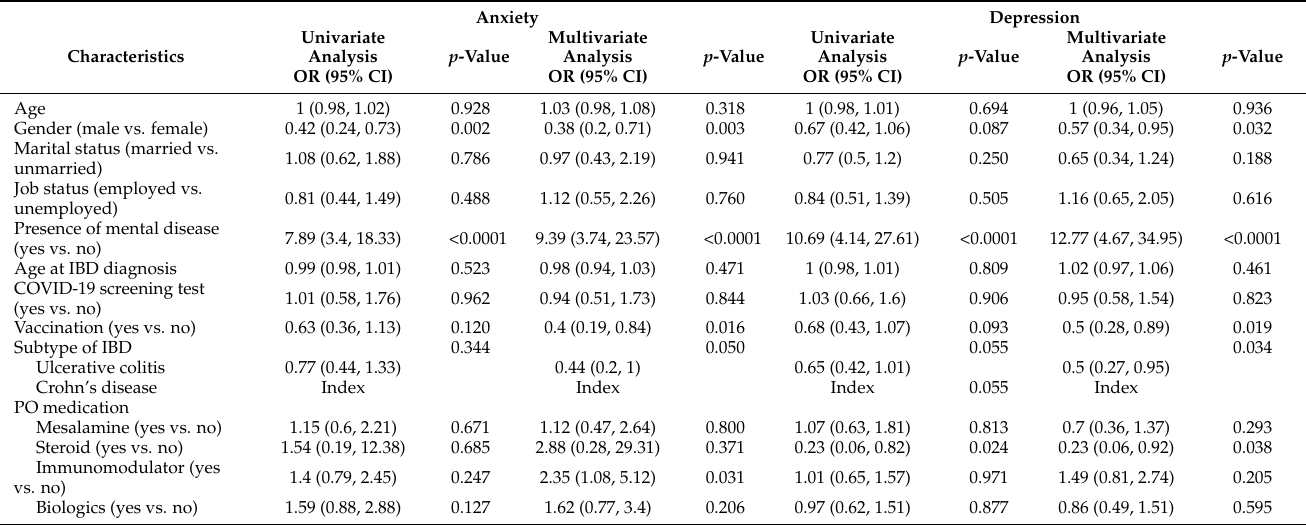
Table 3. Predictors for moderate depression and anxiety.